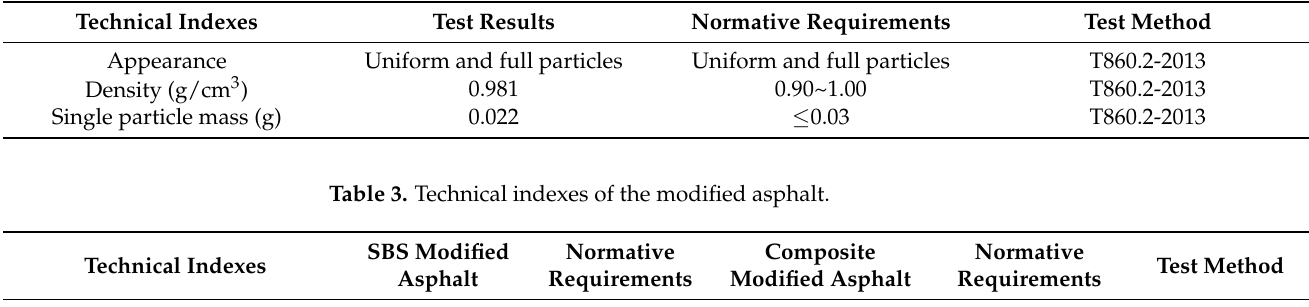
Table 2. Technical indexes of the HVA high-viscosity modifier.